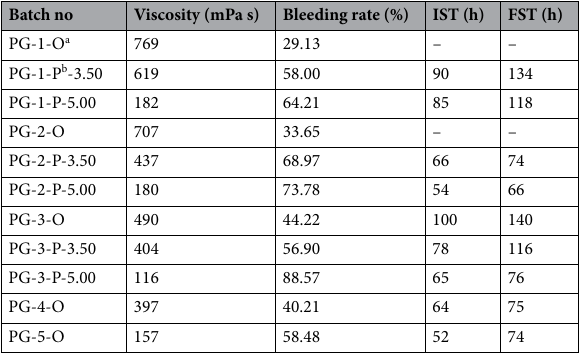
Table 3. Characteristics of backfill slurries prepared using PG with different pH values. a Original. b Pretreatment.